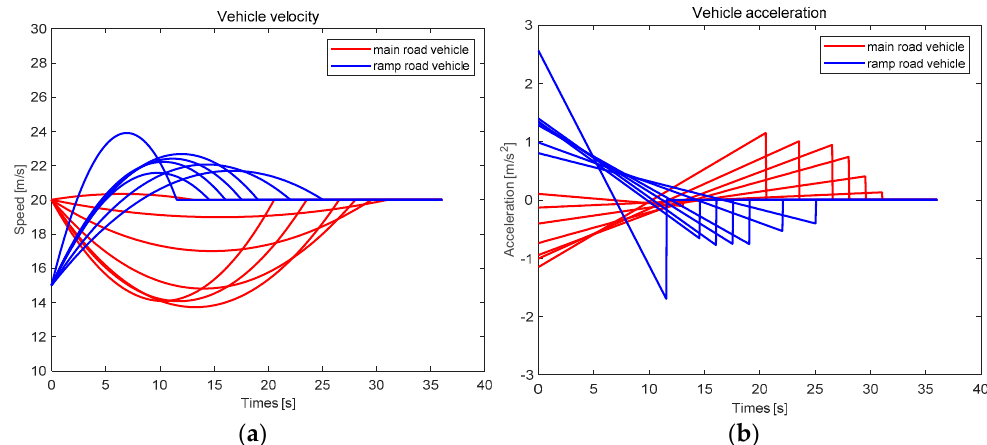
Figure 6. Speed and acceleration of the vehicles for case study 1: ( a ) speed of the vehicles and ( b ) acceleration of the vehicles.